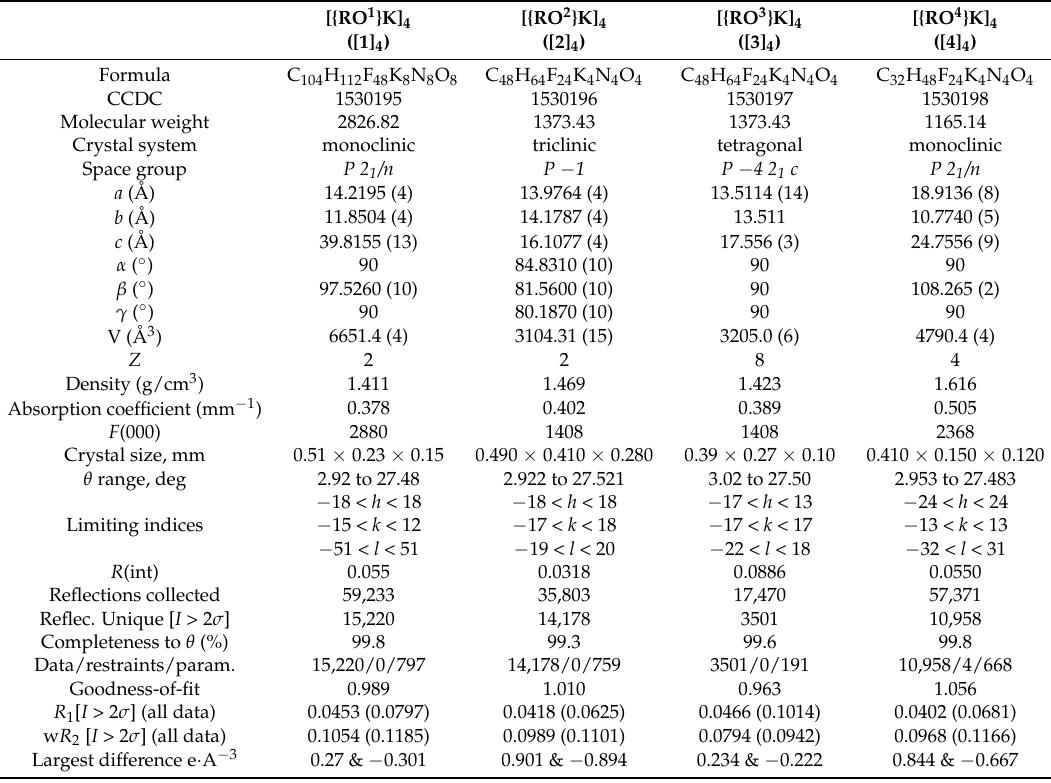
Table 5. Summary of crystallographic data for [ 1 ] 4 –[ 4 ] 4